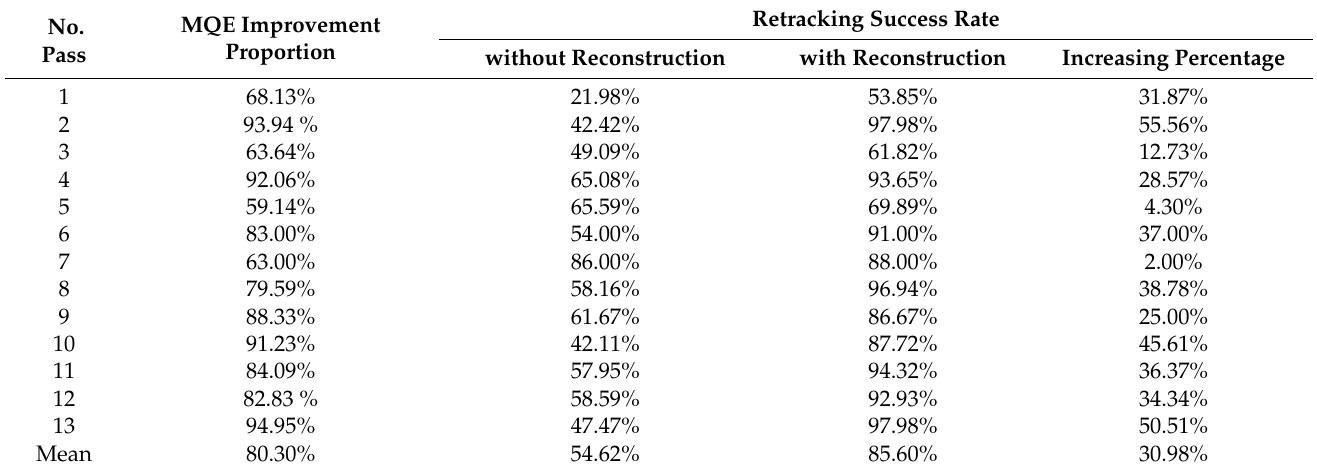
Table 3. MQE improvement proportions and retracking success rates for experimental area